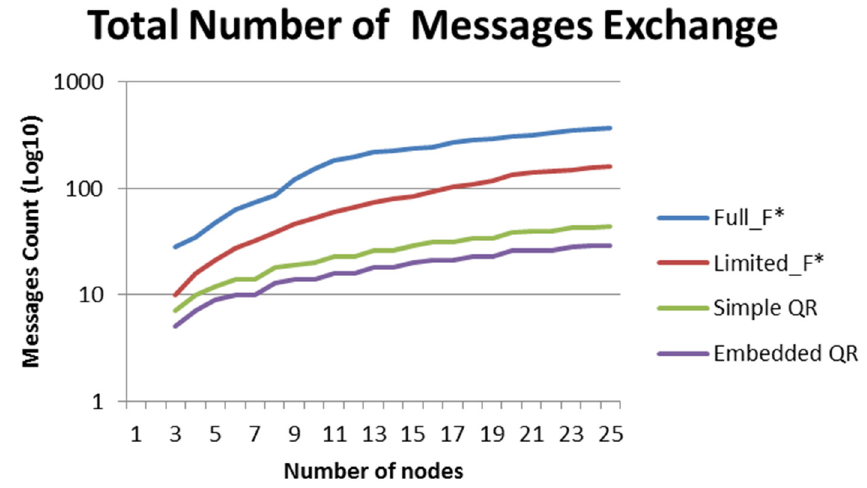
Figure 14. Comparison of total number of messages exchanged by different communication architectures.